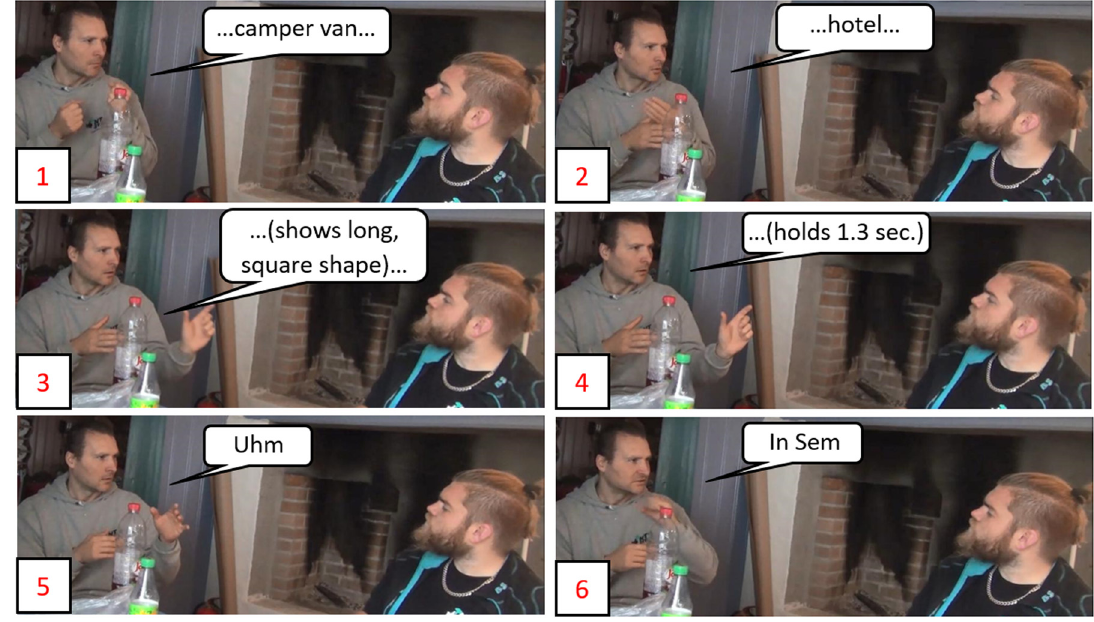
Figure 5: Place reference followed by freeze - look response. ( Lines 6 – 8.